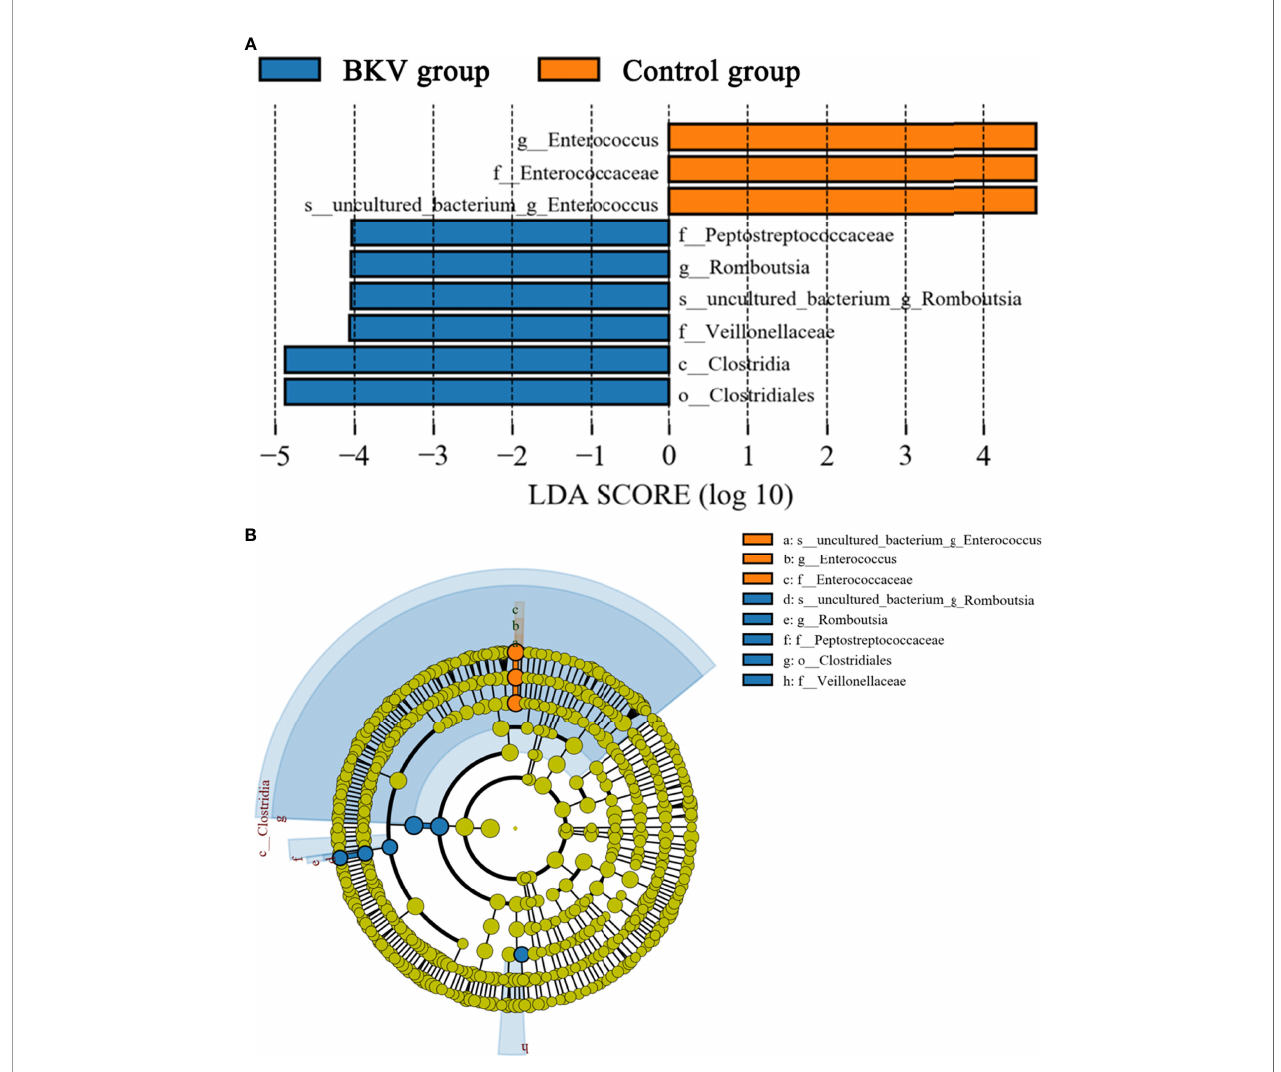
FIGURE 4 | LEfSe analysis between the BKV group and the control group. (A) The LEfSe analysis demonstrated a signi fi cant difference in gut microbiota between the BKV group and the control group, with a log LDA score >4.0. The increase and decrease of bacterial taxa abundance in the BKV group were represented by blue and orange colors, respectively. (B) The cladogram demonstrated relationships among those